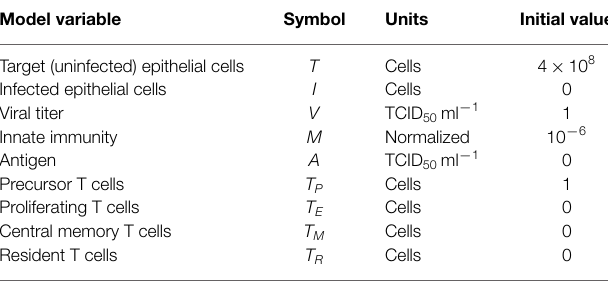
TABLE 2 | Initial values for model variables unless otherwise specified in the figure legend